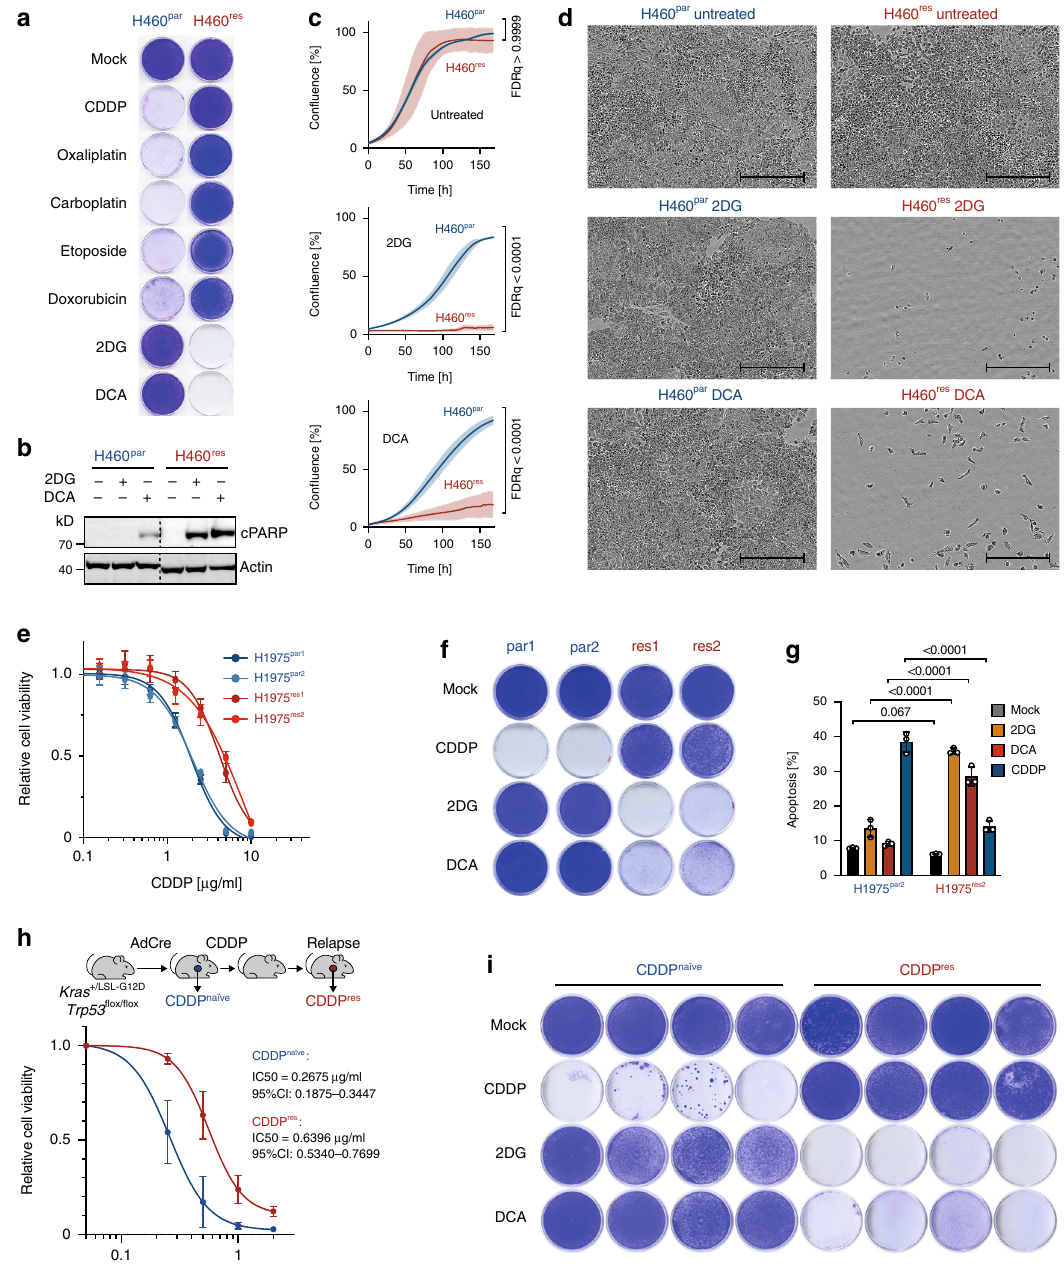
Fig. 1 Metabolic vulnerability of cisplatin-resistant NSCLC. a Clonogenic growth of parental H460 par and CDDP-resistant H460 res NSCLC cells treated with indicated drugs. b Western blot for cleaved Parp (cParp) as apoptosis marker. c , d Proliferation of untreated or 2DG/DCA-treated cells. c Cell culture con fl uency measured by real-time live-cell imaging. Shown are mean ± SD, n = 3, FDR q values. d Representative images of cell cultures at the end of the treatment period. Scale bars, 400 µ m. e Cell viability of two pairs of parental (par1, par2) and CDDP-resistant (res1, res2) H1975 cells treated for 3 days with CDDP. Shown are mean ± SD, n = 3. IC50 (95% CI): par1, 1.9 (1.7 – 2.0); par2, 1.9 (1.7 – 2.0); res1, 4.2 (3.9 – 4.7); res2, 4.5 (4.0 – 4.9). f Clonogenic growth of H1975 cells treated 5 days with indicated drugs. g Flow cytometry analysis for apoptosis (sub-G1) 4 days after treatment with 2DG, DCA, and CDDP. Shown are mean ± SD, n = 3, FDR q values. h Kras G12D/ + ; Trp53 Δ / Δ lung adenocarcinoma cells were obtained from either therapy-naive mice (CDDP naïve ) or mice relapsed after in vivo CDDP therapy (CDDP res ). Cell viability 72 hours following in vitro exposure to CDDP. Shown are mean ± SD, n = 4 cell lines, IC50 (95% CI). i Clonogenic growth of Kras G12D/ + ; Trp53 Δ / Δ lung adenocarcinoma cells in the presence of indicated drugs. Shown are four independent CDDP naïve and CDDP res tumor cell